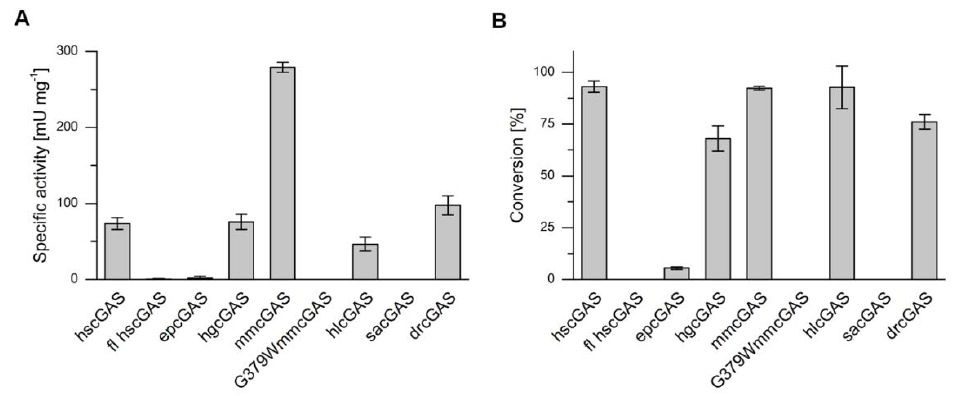
Figure 5. ( A ) Specific activities of cyclic GMP-AMP synthases (cGAS) originating from different metazoans. ( B ) Conversion of ATP by cGAS variants within 24 h. Human (hs), full-length human (fl hs), Przewalski’s horse (ep), naked mole-rat (hg), house mouse (mm), house mouse with amino acid exchange (mmG379W), bald eagle (hl), Sinocyclocheilus anshuiensis (sa), and zebrafish (dr) cGAS. In vitro activity assays were performed at 37 °C with 40 μg mL − 1 cGAS, 0.1 mg mL − 1 HT-DNA, and 0.5 mM ATP and GTP, respectively. Error bars relate to biological triplicates.